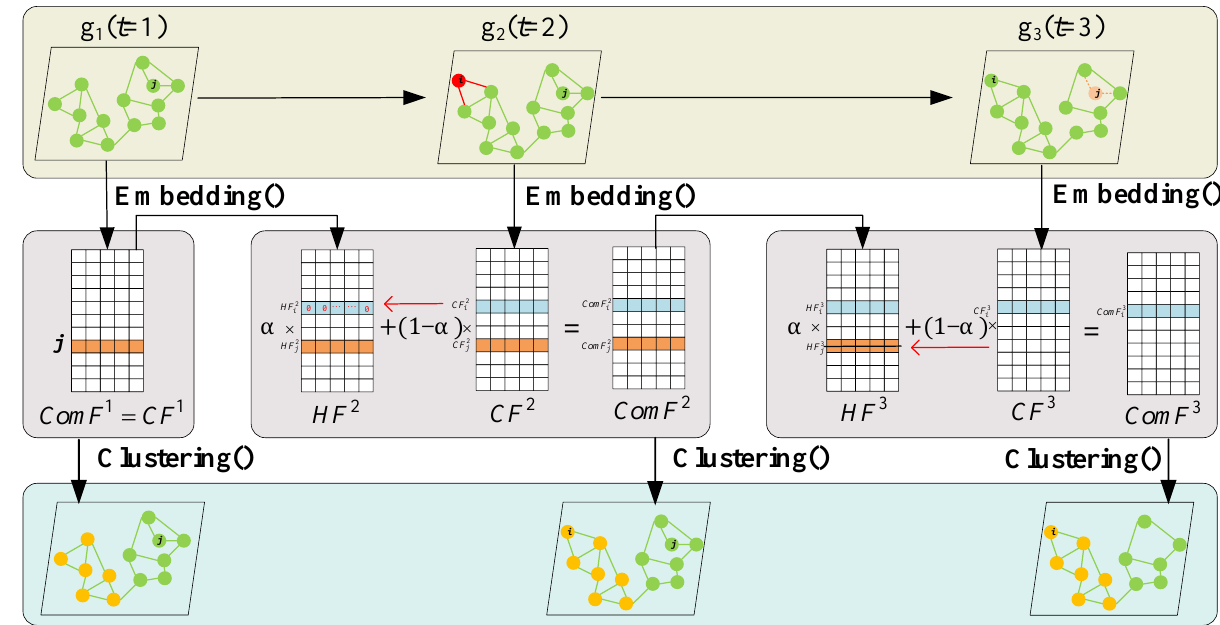
Figure 2. Main framework of DEDW.